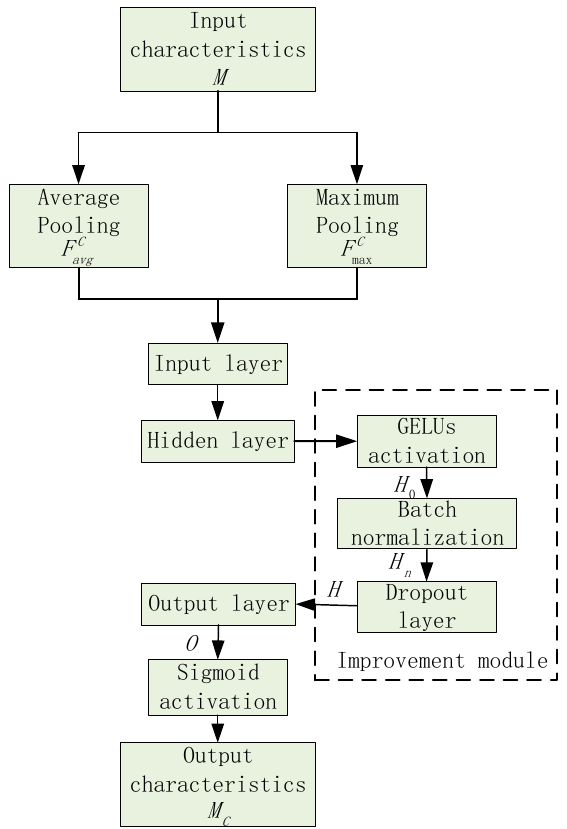
Figure 5. Basic structure of the channel a tt ention model.